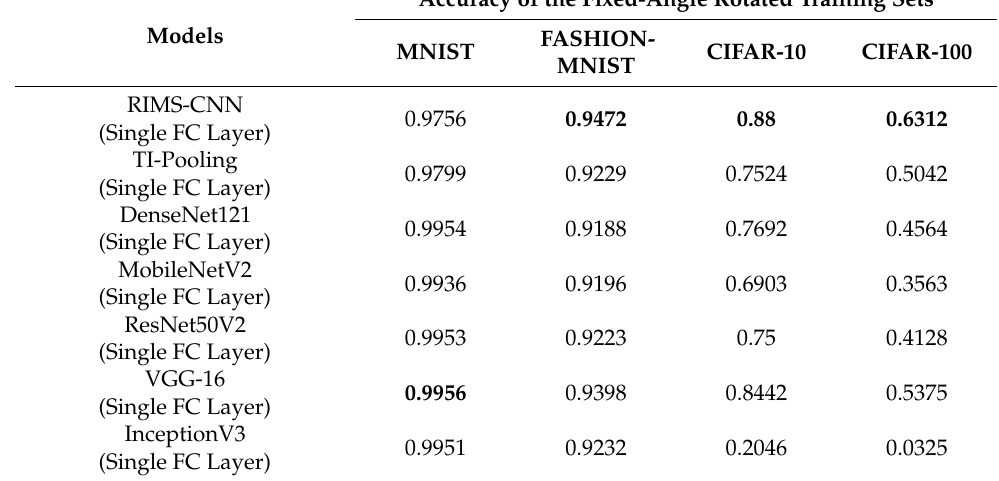
Table 5. Evaluating models on the fixed-angle rotated training sets and the fixed-angle rotated validating